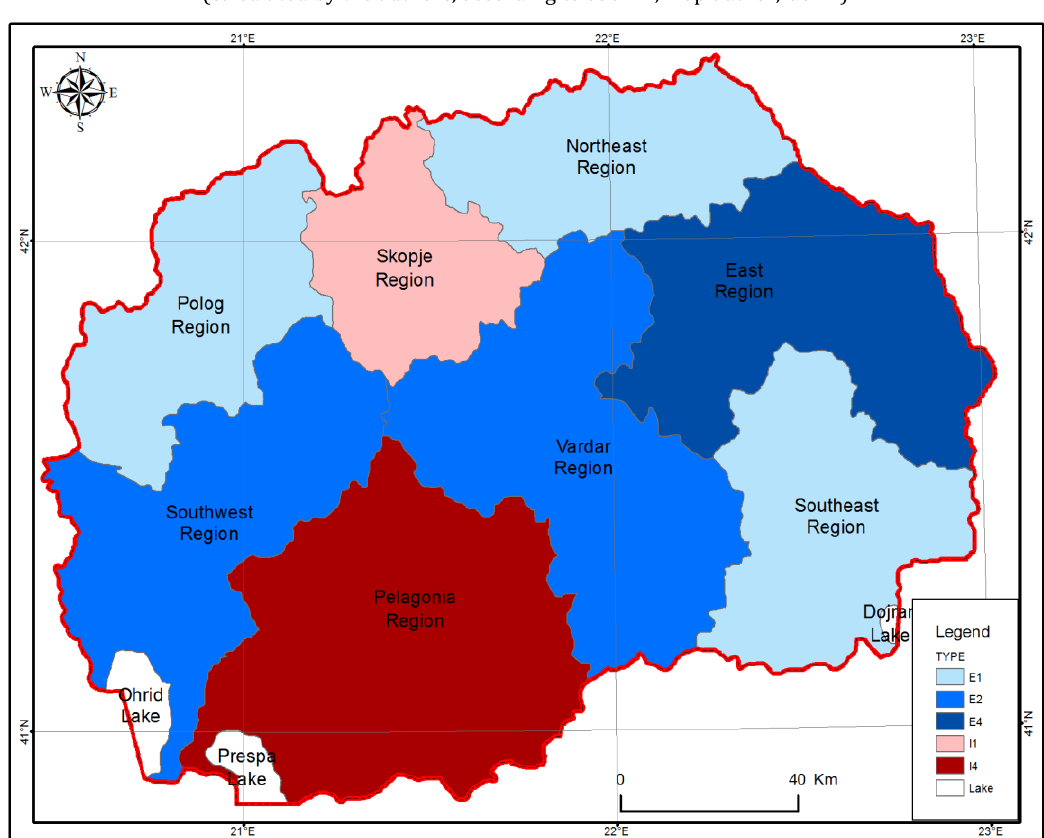
Fig. 9. Migration types, by regions, in the period 2002-2013 (calculated by the authors, according to SSORM, map author,